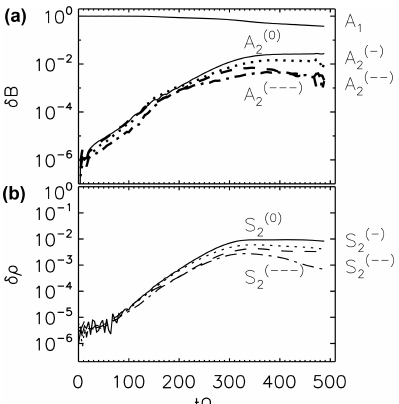
Figure 2. Time evolution of the magnetic field (a) and density (b) fluctuations: Alfvén field-aligned pump A 1 , Alfvén daughter A 2 at selected perpendicular Fourier modes, and corresponding longitu- dinal daughter modes S 2 provided by the three-dimensional hybrid − ) −− ) −−− ) simulation. Symbols of “ A ( 0 ) ”, “ A ( ”, “ A ( ”, “ A ( ”, and 2 2 2 2 − ) −− ) −−− ) “ S ( 0 ) ”, “ S ( ”, “ S ( ”, “ S ( ” denote the mode m numbers 2 2 2 2 ( − 9; 0, 3, 8, 12) and (19; 0, 3, 8, 12), respectively. The propagation angles θ of the density daughter modes have values close to 10 ◦ (dotted), 20 ◦ (dashed), and 30 ◦ (dashed